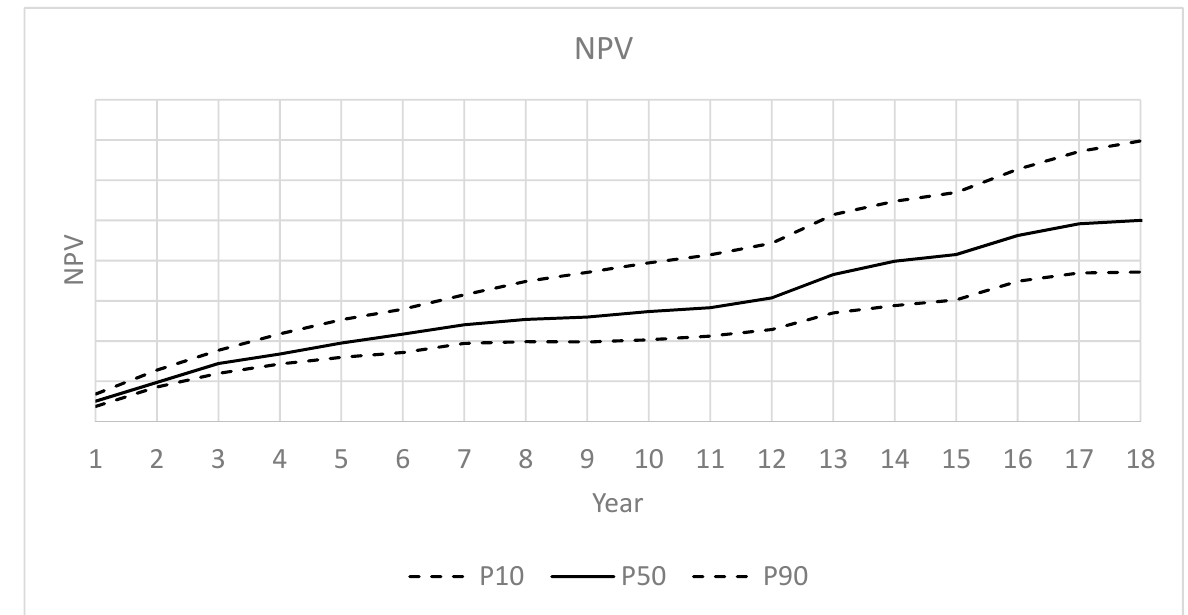
Figure 2. Net present value of the Rosebel Gold Mines (RGM) mining complex.